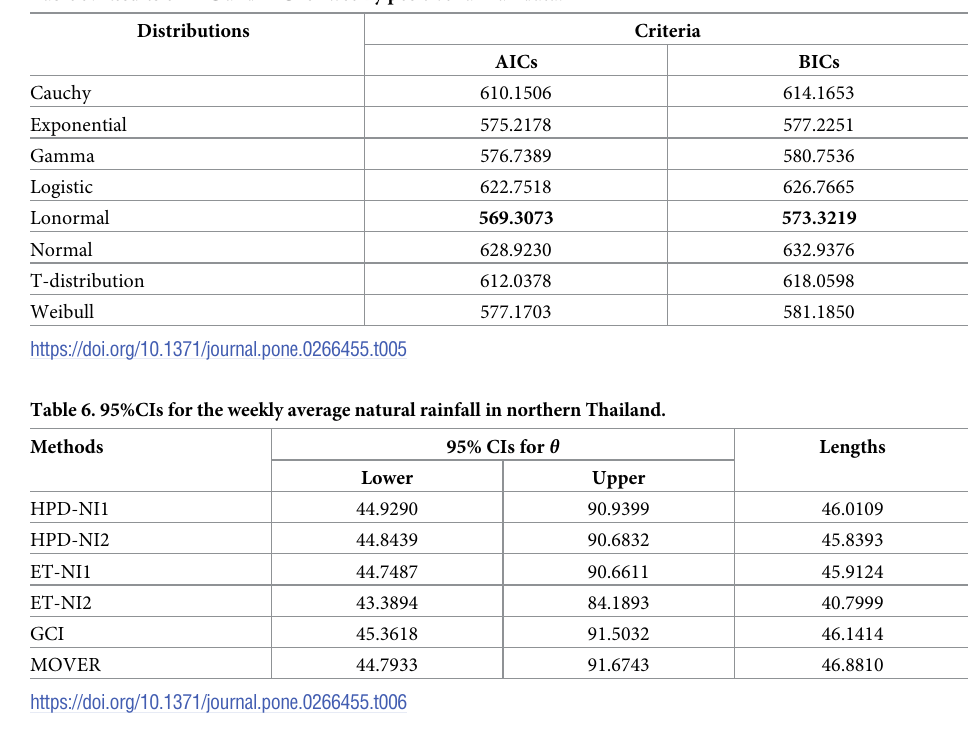
S1 Fig. Performance measures of 95%CIs for θ : a = 1. (A) Coverage probabilities and (B) Expected lengths.